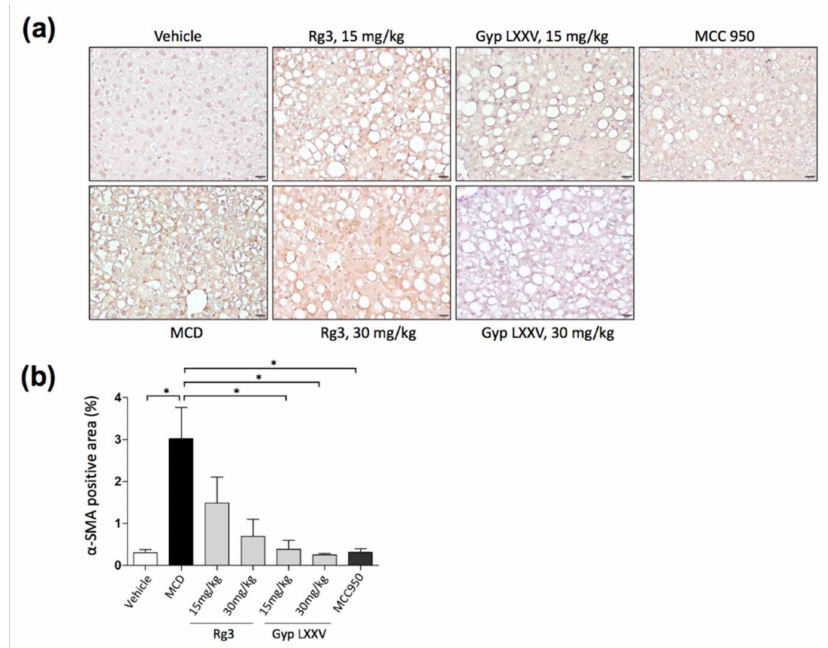
Figure 6. Immunohistochemical staining of α -SMA in liver samples ( a ). The distribution of hepatic fibrosis in the MCD diet mouse model with or without Gyp LXXV or Rg3 was investigated. 400 × magnification, scale bar 20 µ m. Quantification of immunohistochemistry (IHC) for α -SMA was performed using Fiji software ( b ). Error bars represent SEM. * p < 0.05 vs. MCD, two tailed unpaired